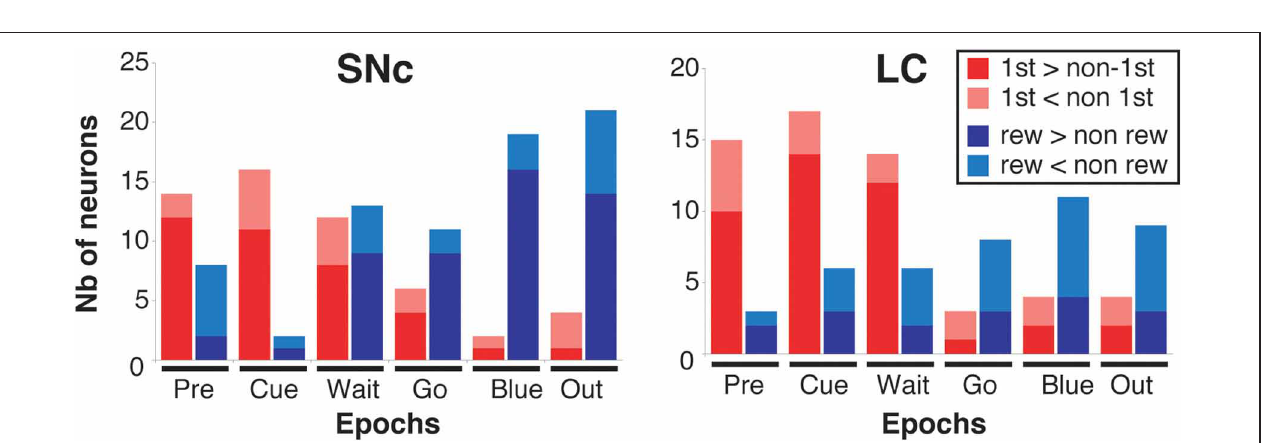
FIGURE 7 | Response modulation across epochs of a trial. Number of neurons showing a significant modulation of their firing between first and non-first (First modulation) or between rewarded and unrewarded trials (Reward modulation) in the SNc (left) and the LC (right) , across the six epochs of a trial (see text and Figure 6 for a description of these epochs). The analysis was conducted on the entire population of recorded neurons (SNc: n = 75, LC: n = 63), without any selection based on their activity in the task. Each bar indicates the total number of neurons showing a significant